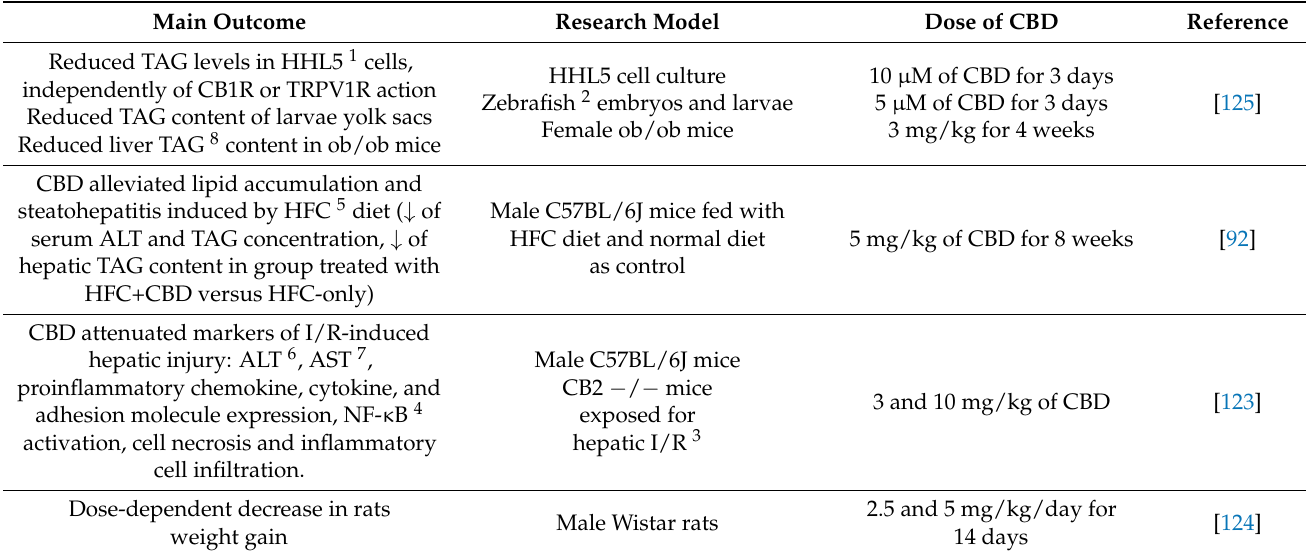
Table 3. Studies analyzing the in vitro and in vivo effects of CBD in NAFLD and related diseases. Main Outcome Research Model Dose of CBD